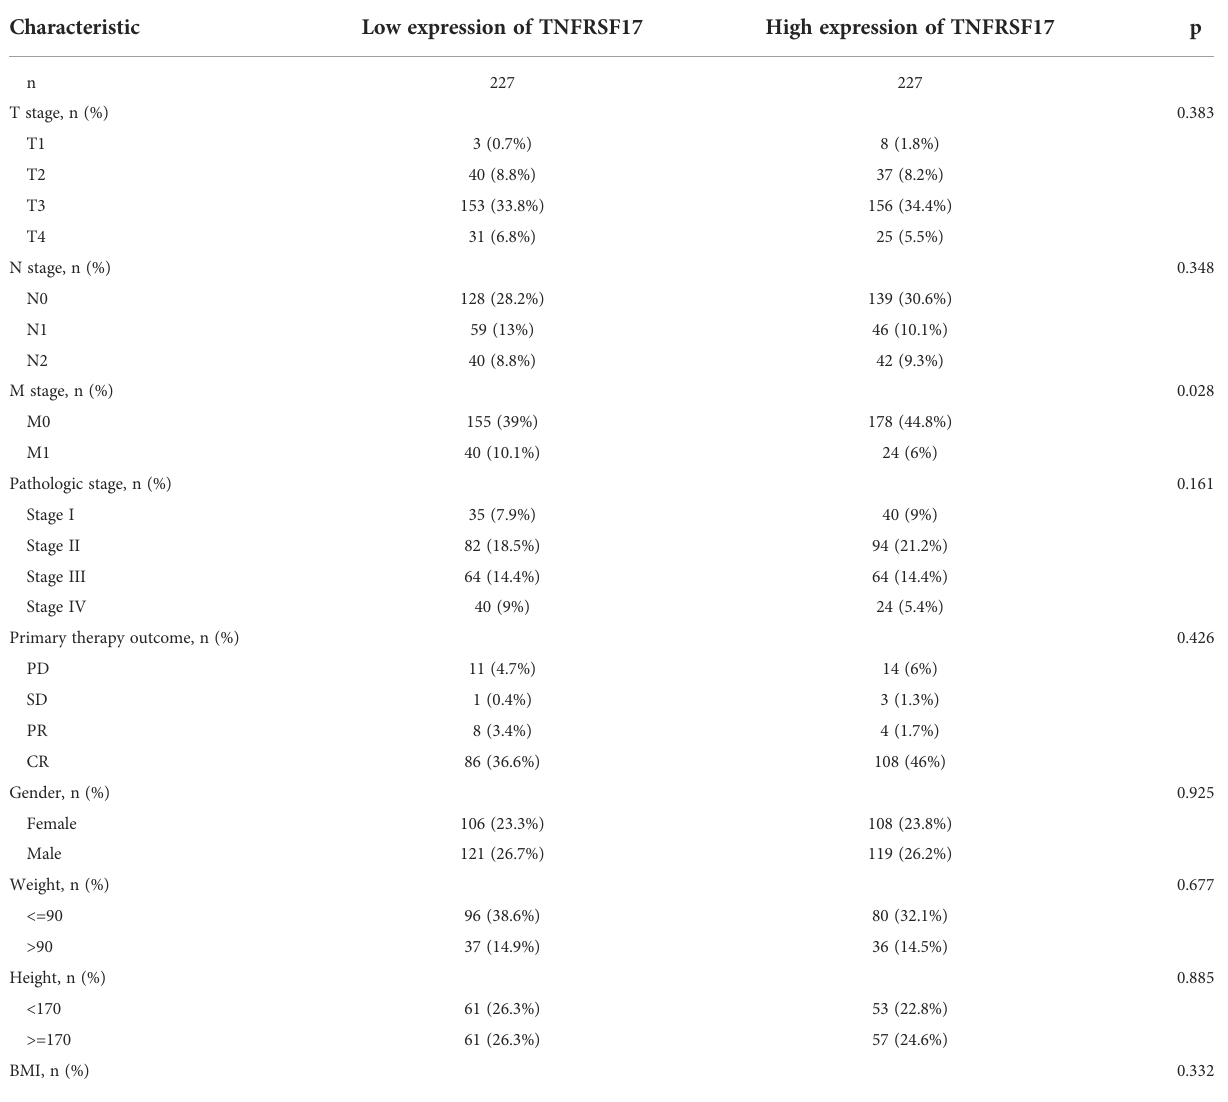
TABLE 2 Analysis of correlation between expression of TNFRSF17 and